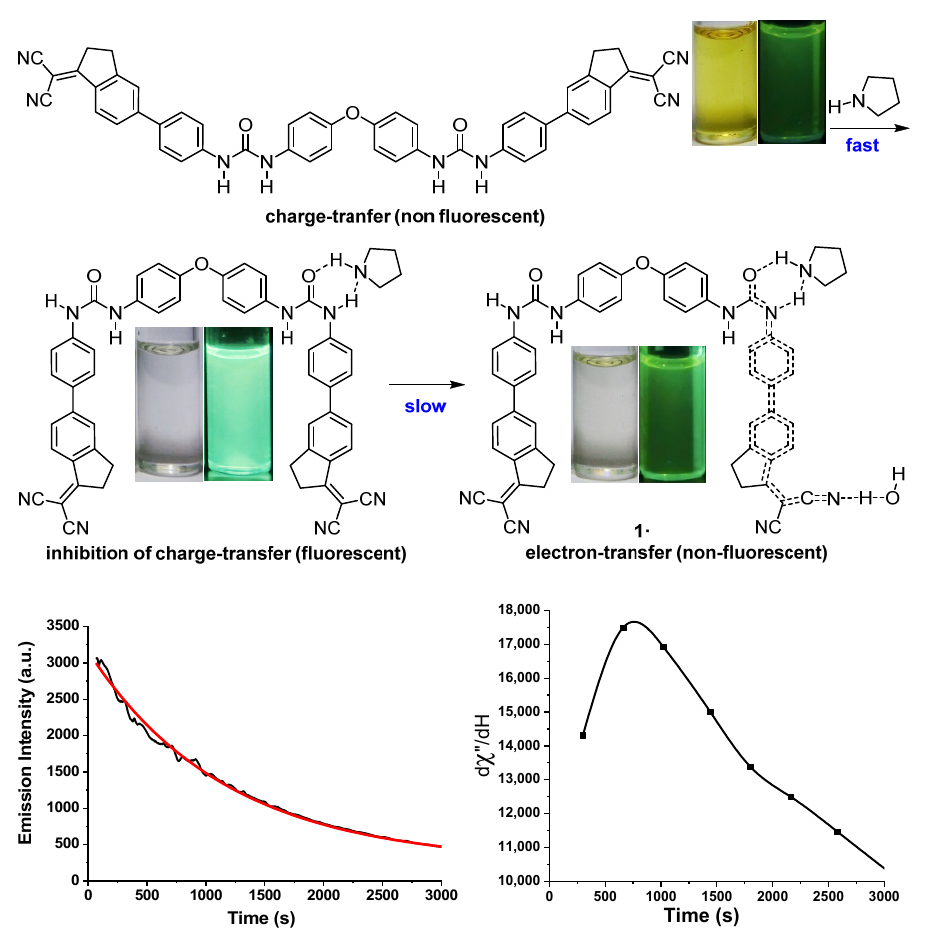
Figure 9. (Top) A summary of the formation and evolution of [ 1 ] • . (Bottom left) Fluorescence measured (black line) and fitting curve (red line) for the fluorescence intensity decay process of a 10:1 pyrrolidine/ 1 solution, concentration C 1 = 5.0 × 10 − 5 M in 3:1:1 ( v / v ) DMSO/water/acetone. (Bottom right) EPR spectral evolution with time for a solution of 1 and pyrrolidine in DMSO/water/acetone under the conditions reported in Figure 2. Insets: Images of the solutions under white light (left) and under UV light (366 nm) (right).